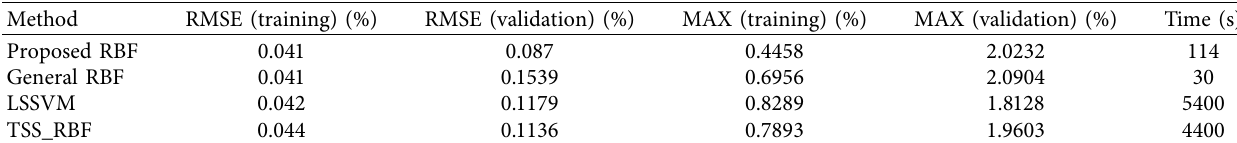
Table 2: Performance for the SOC estimation using different